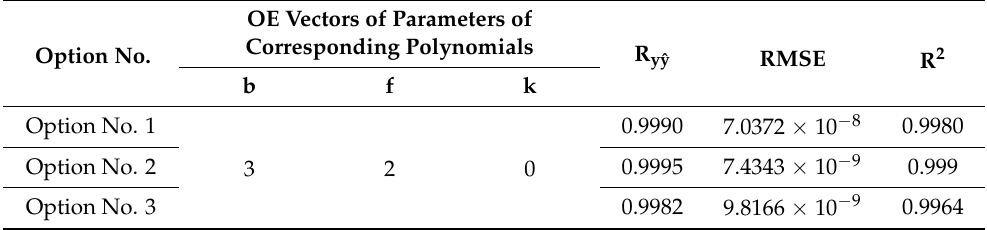
Table 2. R yˆy , RMSE, and R 2 coefficients of obtained SI algorithm using ARMAX model and compara- ble generator.